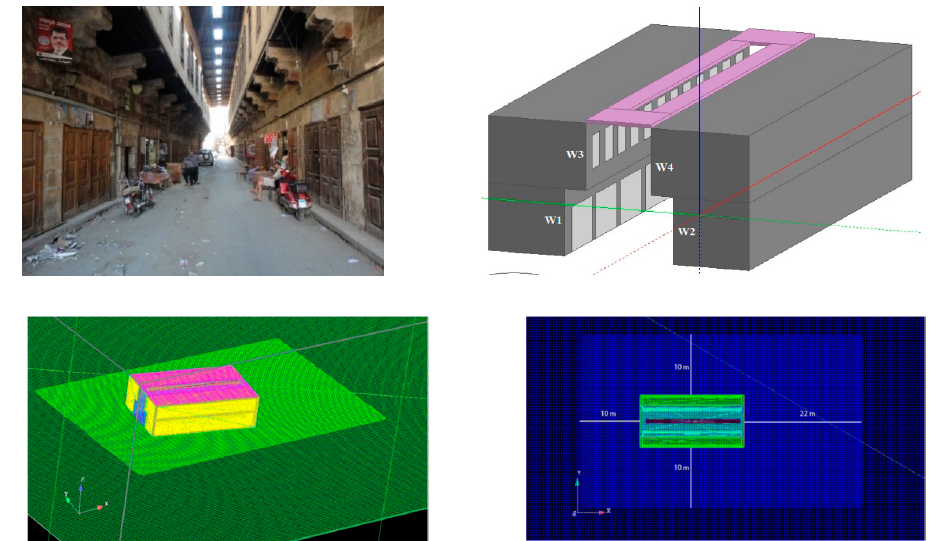
Figure 5. The meshing domain for the existing case, with the coarsened area 10 m above the model. The mesh spacing was coarsened with 0.48 m as minimum spacing. Recommended skewness is